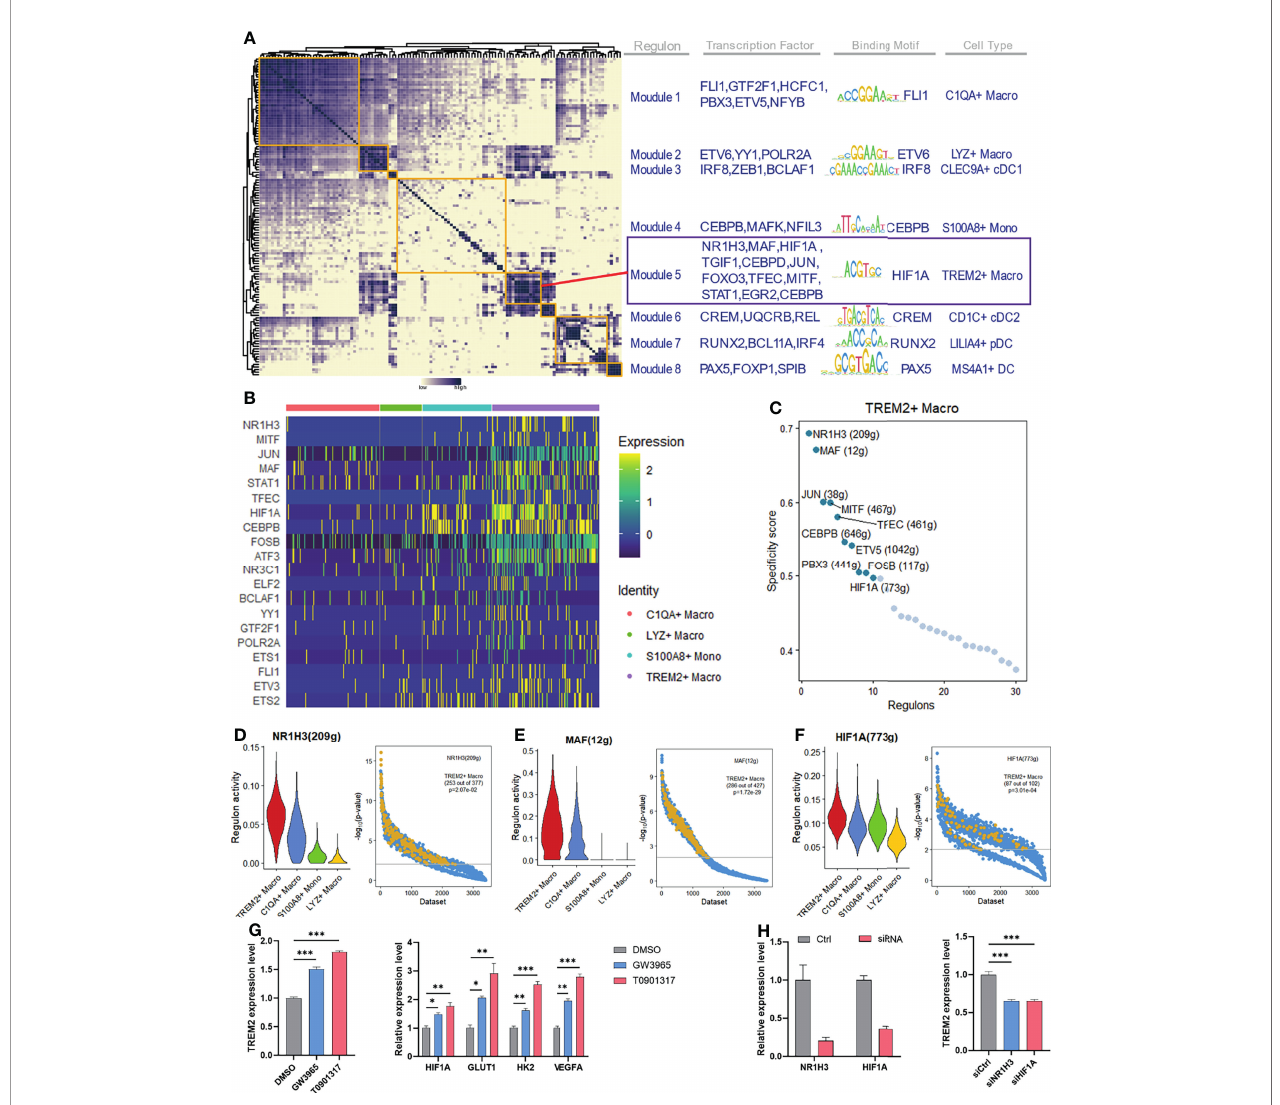
FIGURE 6 | Identi fi ed speci fi c regulators of the maintenance of TREM2 + macrophage identity. (A) Identi fi cation of regulon modules based on the regulon connection speci fi city index matrix in myeloid cells, along with representative transcription factors, corresponding binding motifs, and associated cell subtypes. (B) Heatmap showing the expression of the selected transcription factors across monocyte – macrophage subtypes. Columns denote cells; rows denote genes. (C) Rank of the regulons in TREM2 + macrophages based on the regulon speci fi city score. The g within the bracket indicates genes. (D – F) Violin plots showing the regulon activity in TREM2 + macrophages (left) and SEEK coexpression results for target genes of the indicated regulon in different GEO datasets. TREM2 + macrophage-related datasets with a signi fi cant correlation ( P < 0.01) are highlighted by yellow dots. (G, H) PMA-induced THP-1 cells were treated with LXR agonists (G) or siRNAs (H) . The relative expression levels of the indicated genes were determined by qRT-PCR. Signi fi cance was assessed using one-way ANOVA with Tukey ’ s post hoc test. * P <0.01; ** P <0.01; *** P